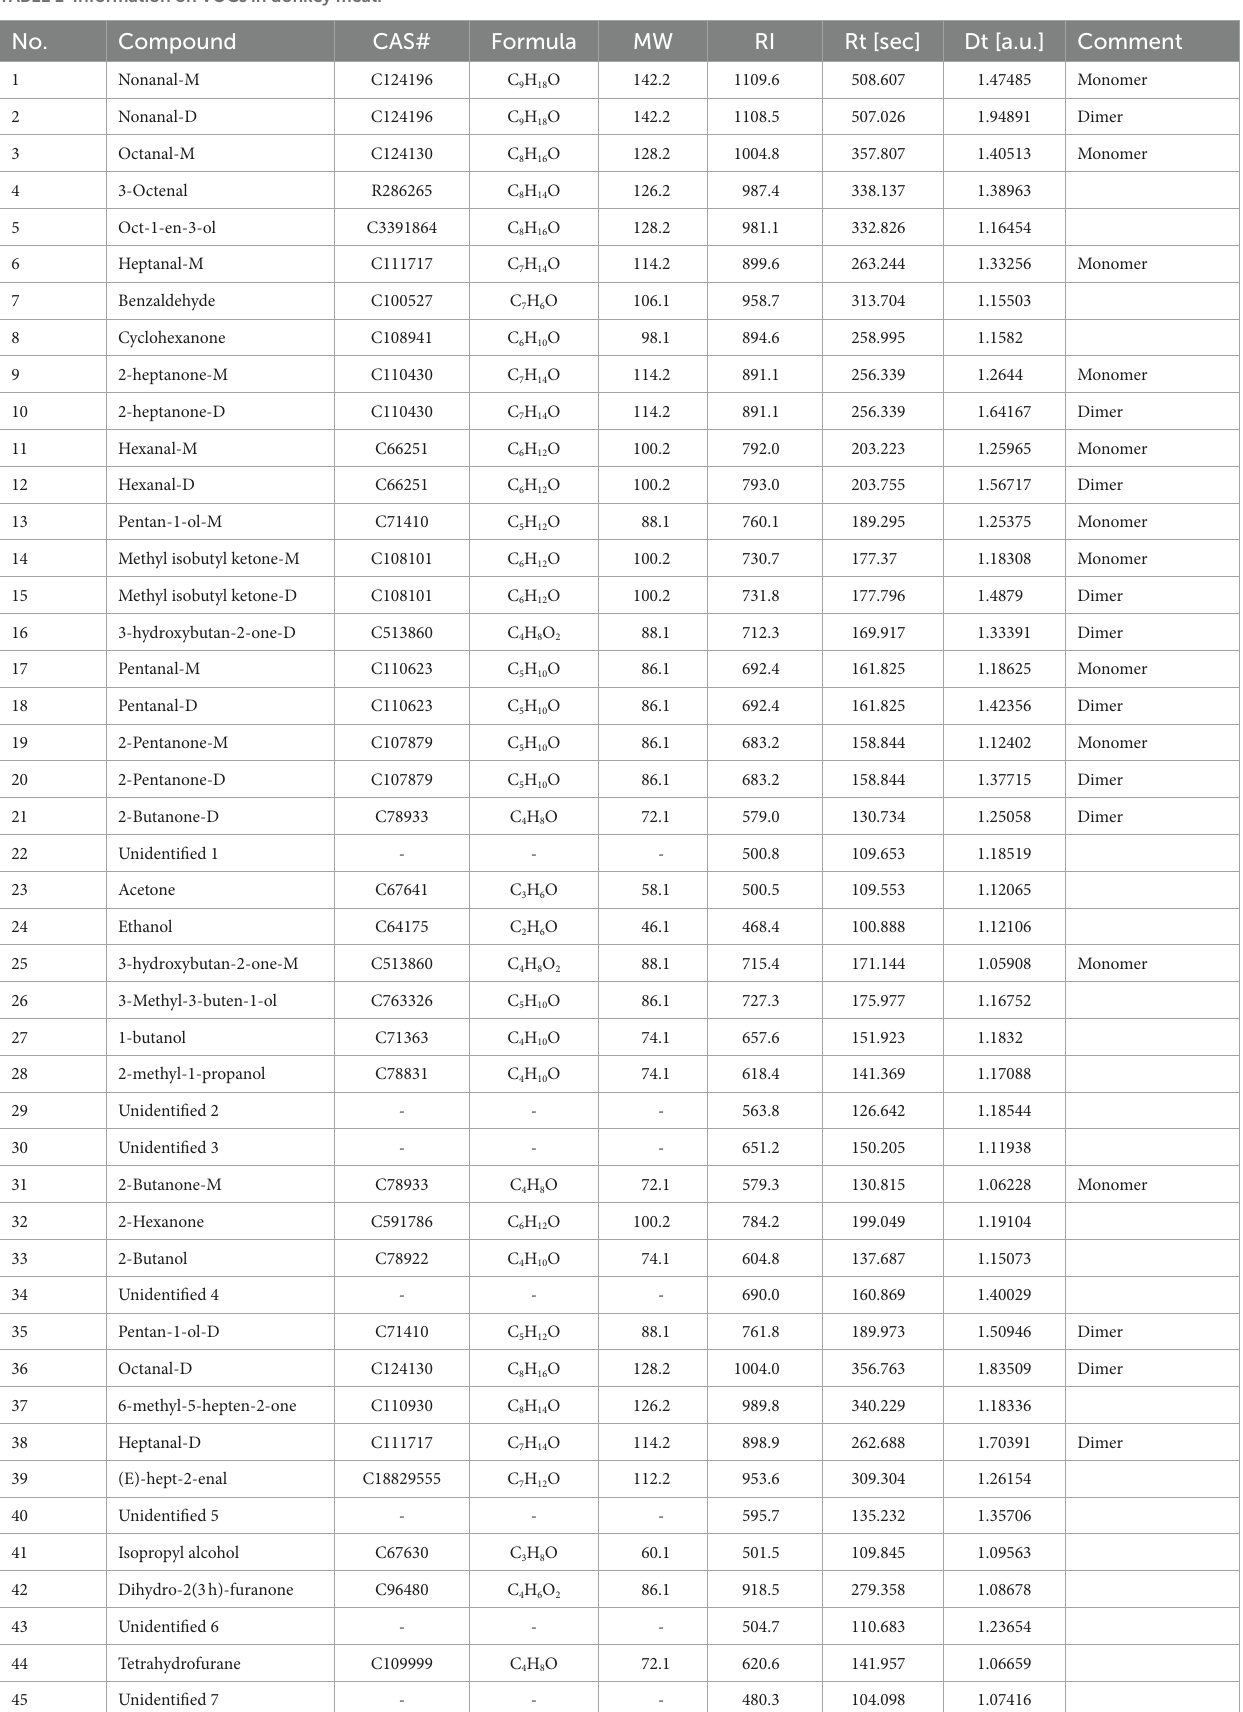
TABLE 1 Information on VOCs in donkey